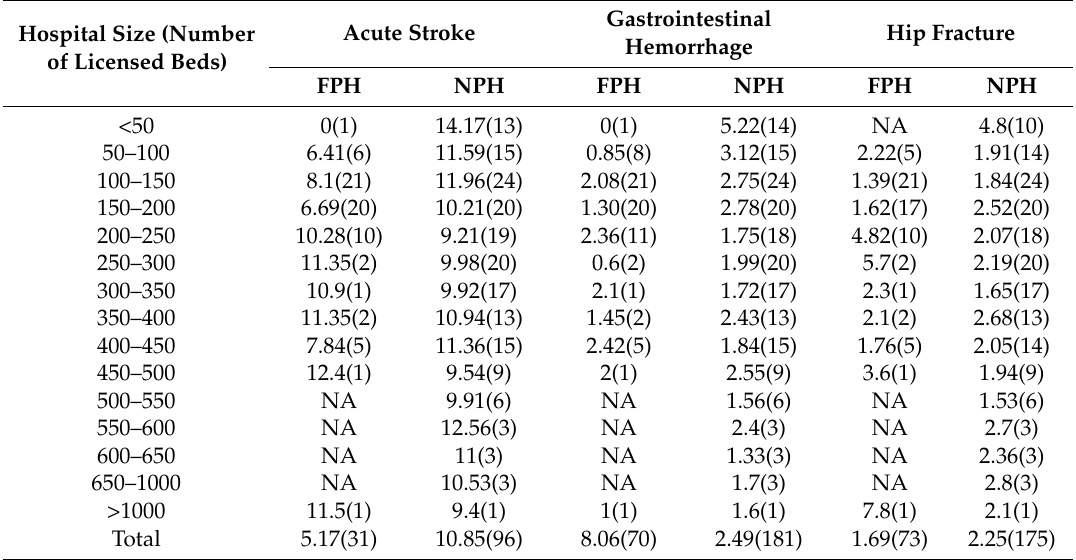
Table 5. Hospital Quality (In-Hospital Deaths after Treatment for Specific Medical Conditions— Risk-adjusted Mortality